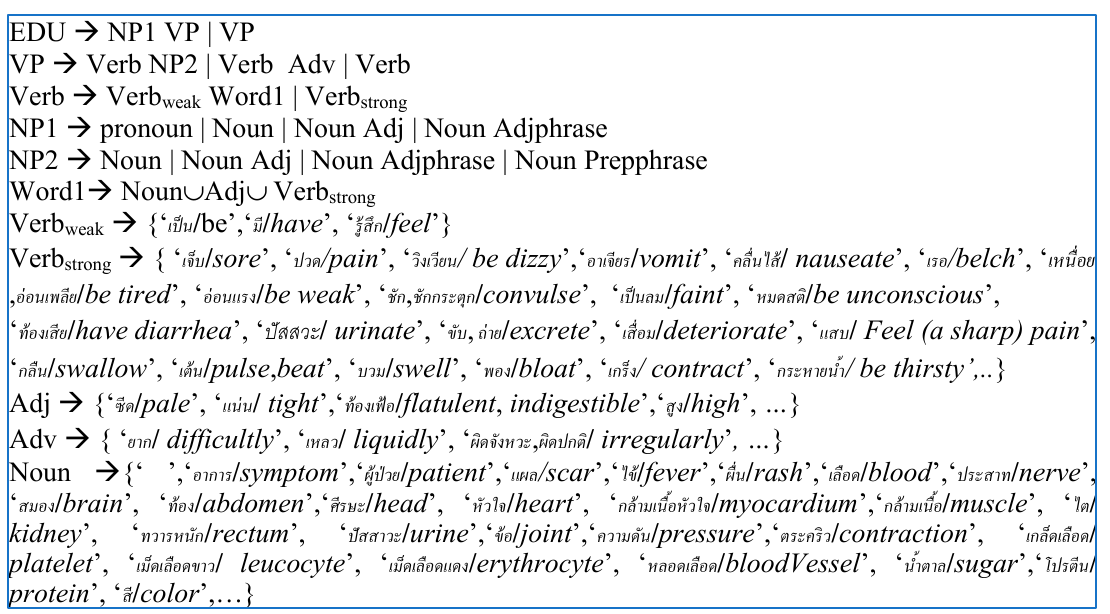
Figure 2. A general Thai linguistic expression including Thai-to-English translation by Lexitron